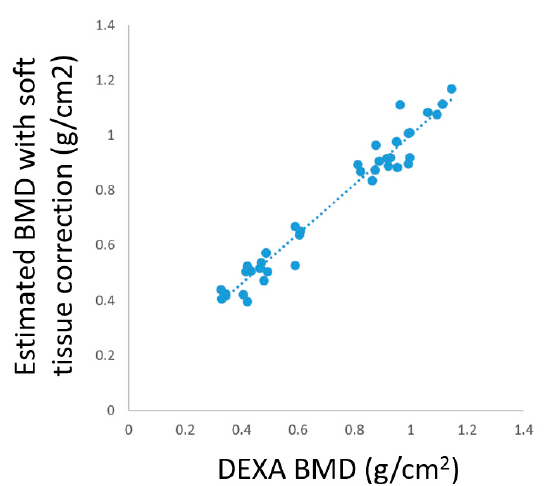
Figure 11. Correlation analysis between DEXA BMDs and estimated BMDs with soft tissue correction. Table 5. Comparison between estimated BMDs and DEXA BMDs (in g/cm 2 ).